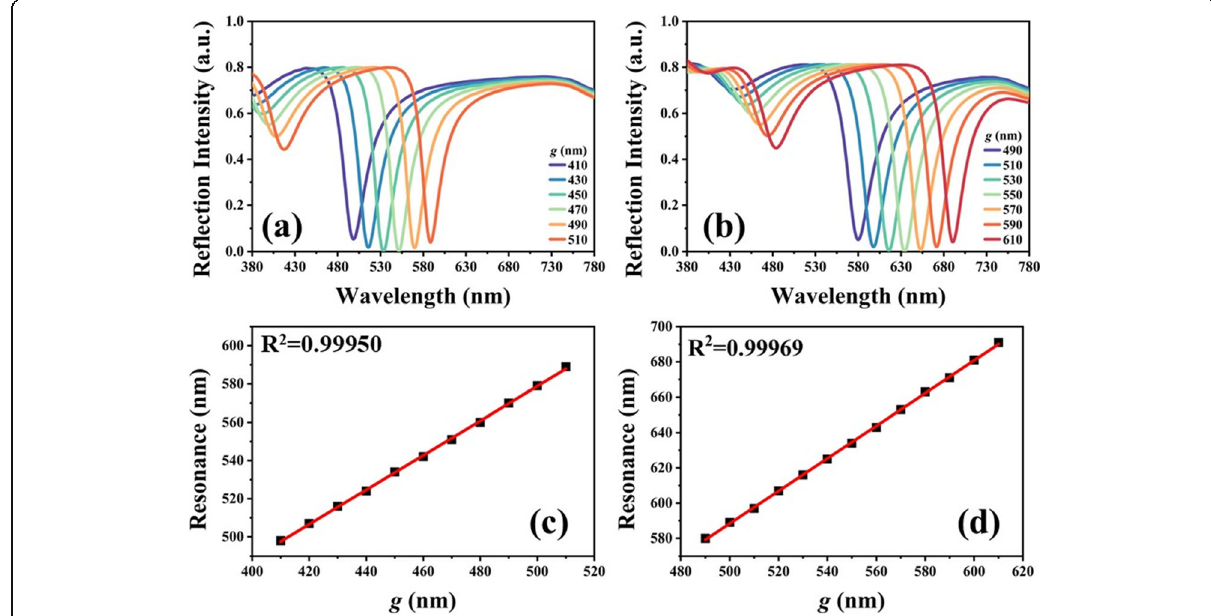
Fig. 3 Reflection spectra of TAM with different g values under the conditions of a D y = 200 nm, b D y = 250 nm. c, d The relationships of resonances and g values of a and b , respectively